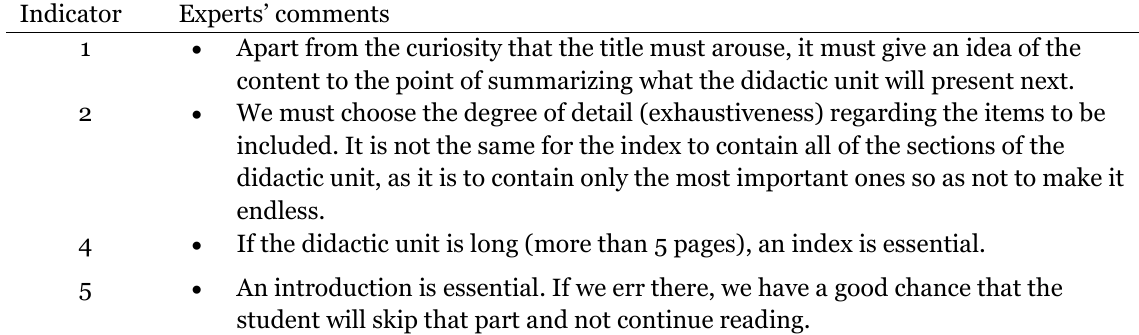
Results of the Qualitative Validation of the System Indicators: Experts’ Comments